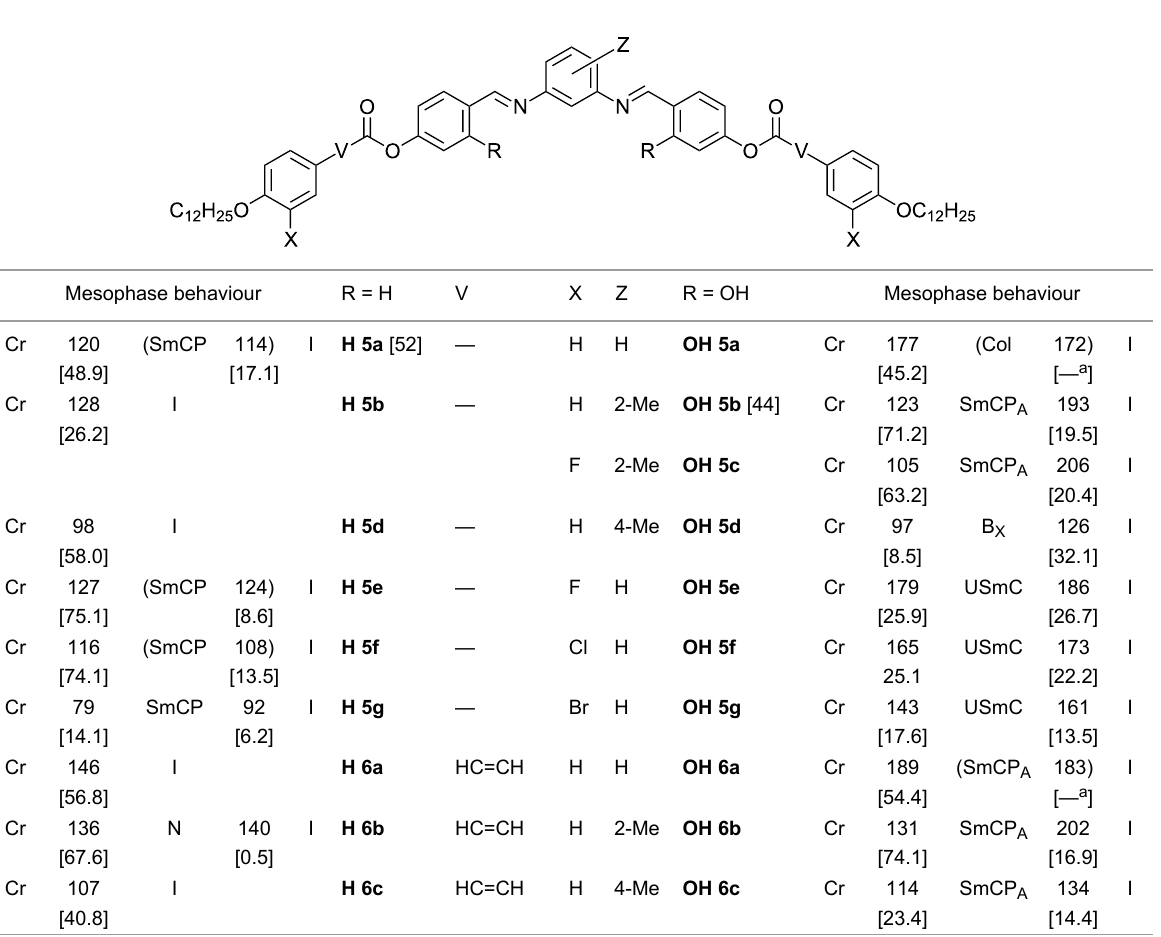
Table 5: Mesophase behaviour, transition temperatures (°C) and enthalpies [kJ/mol] of compounds OH 5 and OH 6 (on the right) and corresponding compounds H 5 and H 6 (on the left).